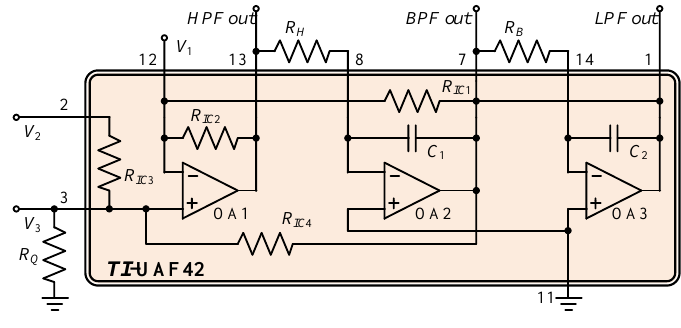
Figure 8. Schematic of the universal active filter TI -UAF42.